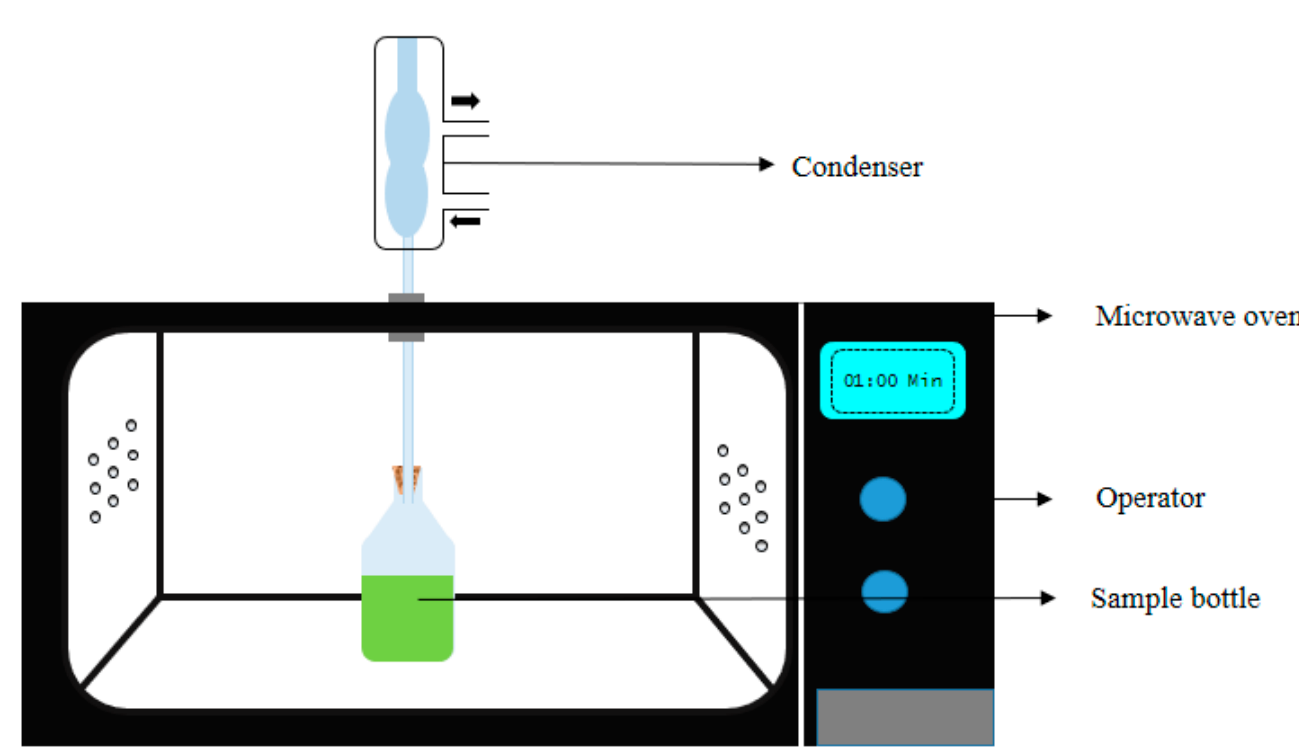
Figure 3. Schematic representation of the microwave-assisted extraction Figure 3 . Schematic representation of the microwave-assisted extraction apparatus .